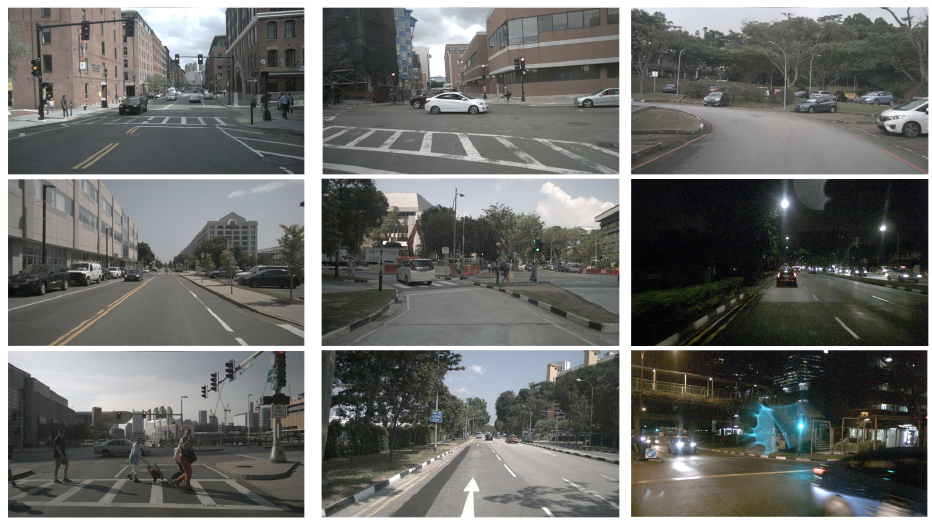
Figure 16. Images of nuScenes